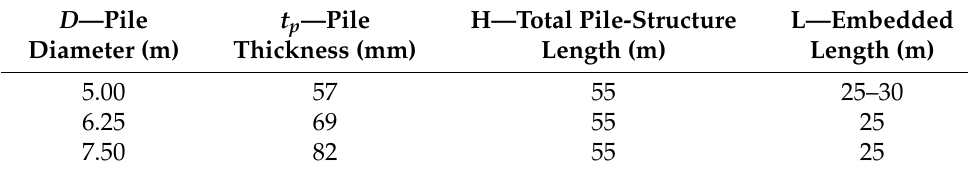
Table 1. Pile geometrical properties.